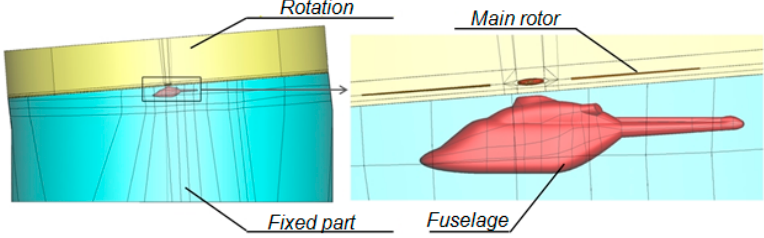
Figure 4. Far and near view of the computation domain.